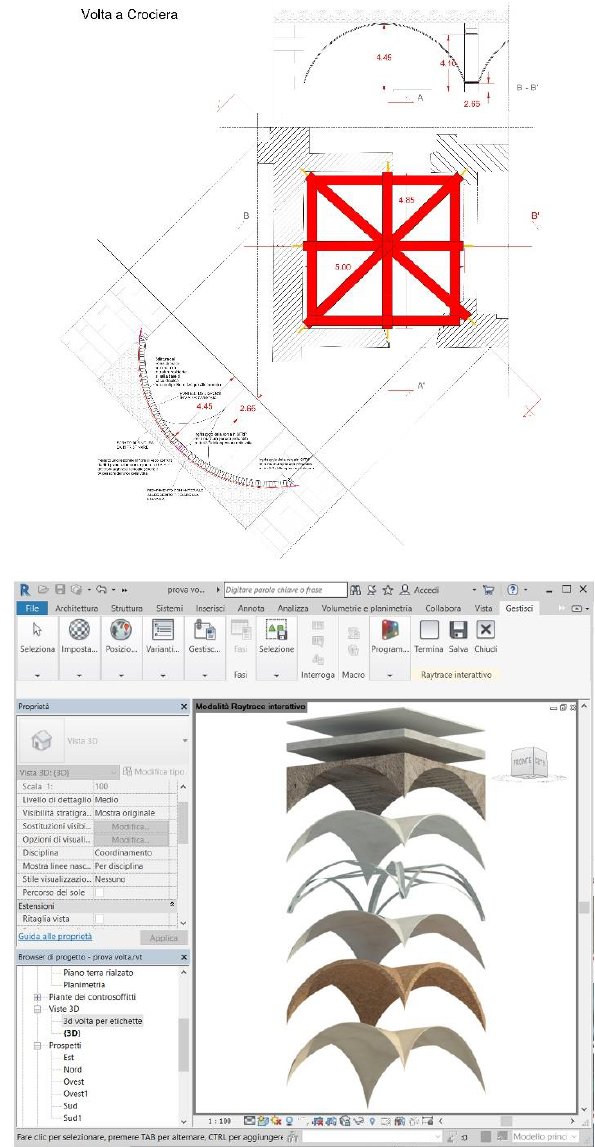
Figure 4: The model of a vault of Palazzo Camponeschi in L’Aquila (17th century) and the sources of information for the modelling of its construction technologies: example of Level of Quality